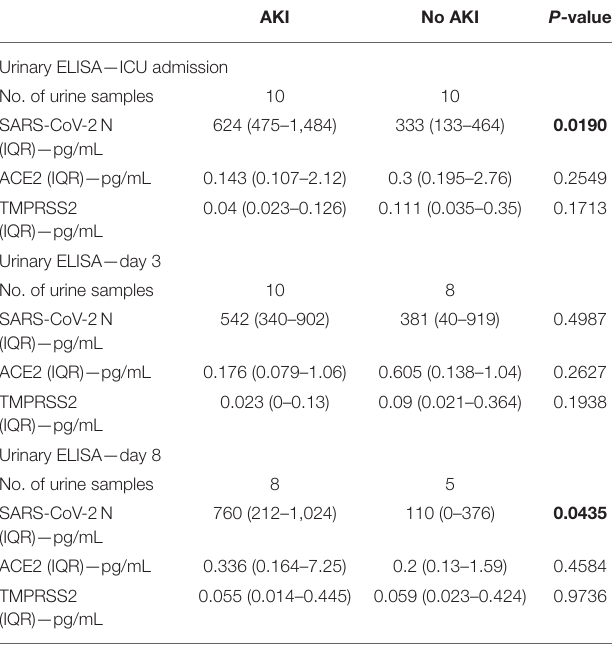
TABLE 2 | Association between AKI in COVID-19 and urinary SARS-CoV-2 N, ACE2, and TMPRSS2. AKI No AKI P